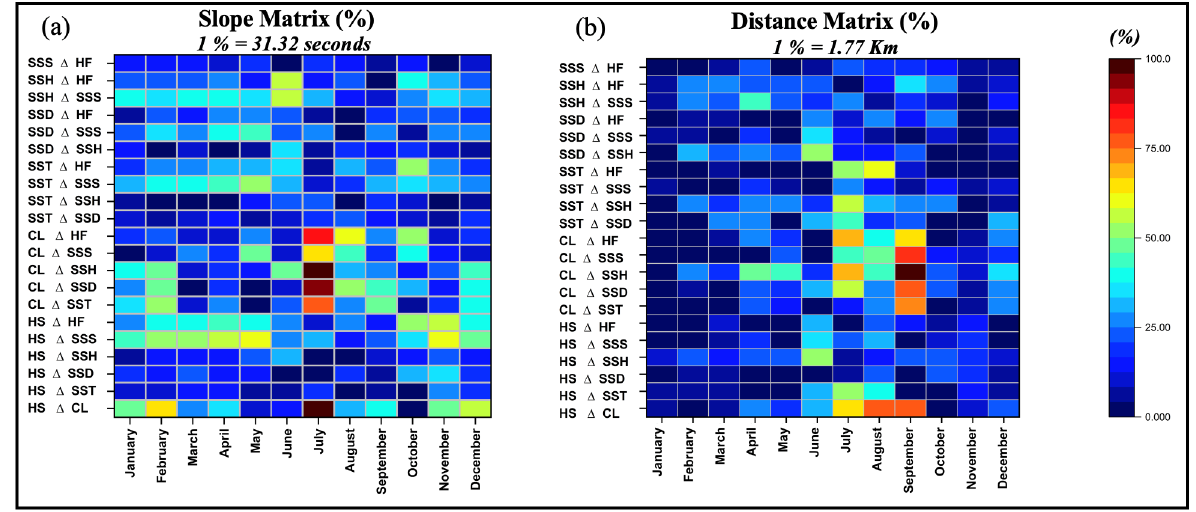
Figure 10. Inter-comparison of KC climatological centerline from heat flux (HF), SST, SSS, SSD, chlorophyll- α (CL), SSH, and sea surface current (HS) using ( a ) slope matrix; ( b ) distance